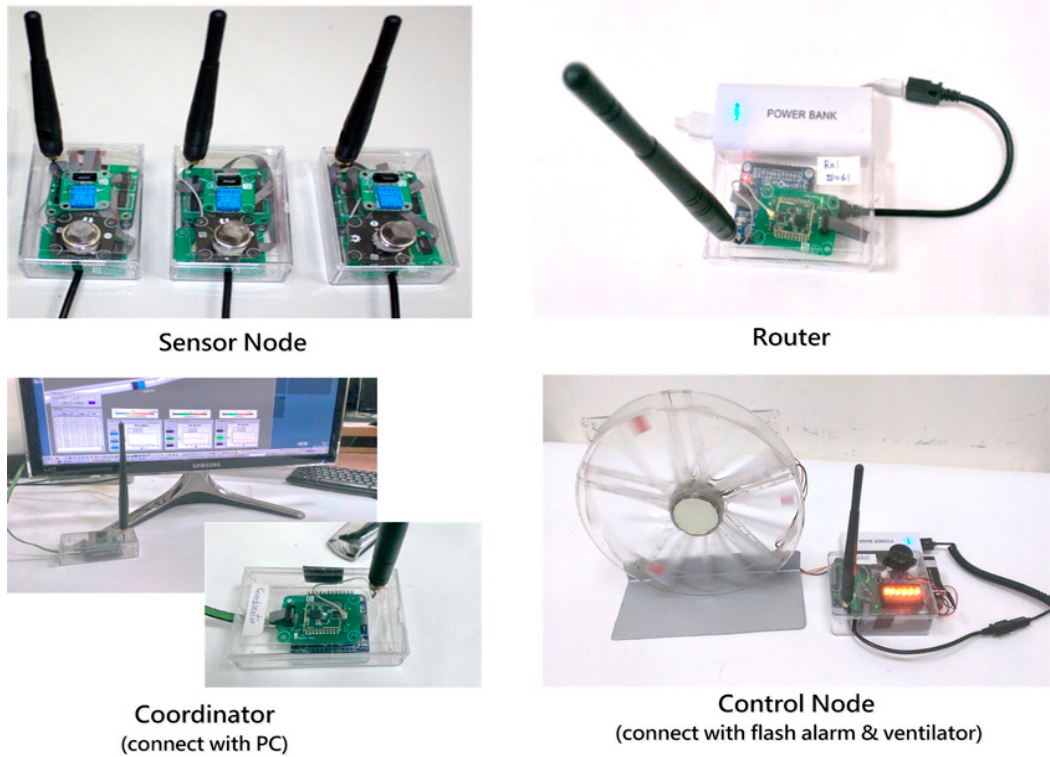
Figure 9. The types of all proposed WSN nodes.